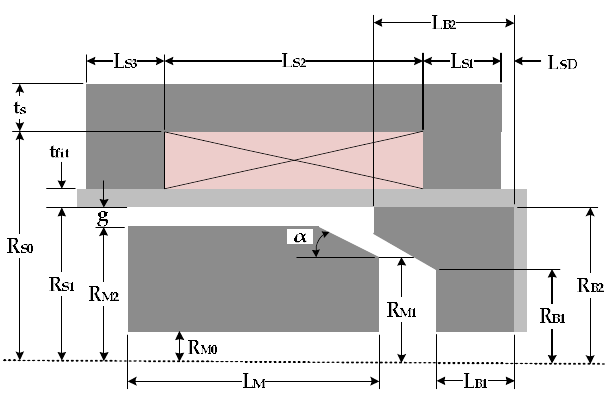
Figure 7. Air gaps magnetic flux path: ( a – c ) front end; and ( d ) rear end.